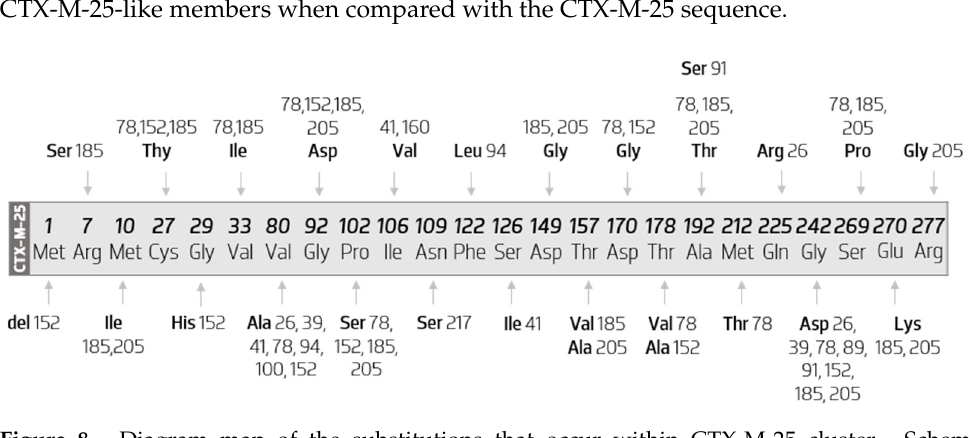
Figure 8. Diagram map of the substitutions that occur within CTX-M-25 cluster. Scheme based on available sequences and phenotypes in the Bacterial Antimicrobial Resistance Reference Gene Database.